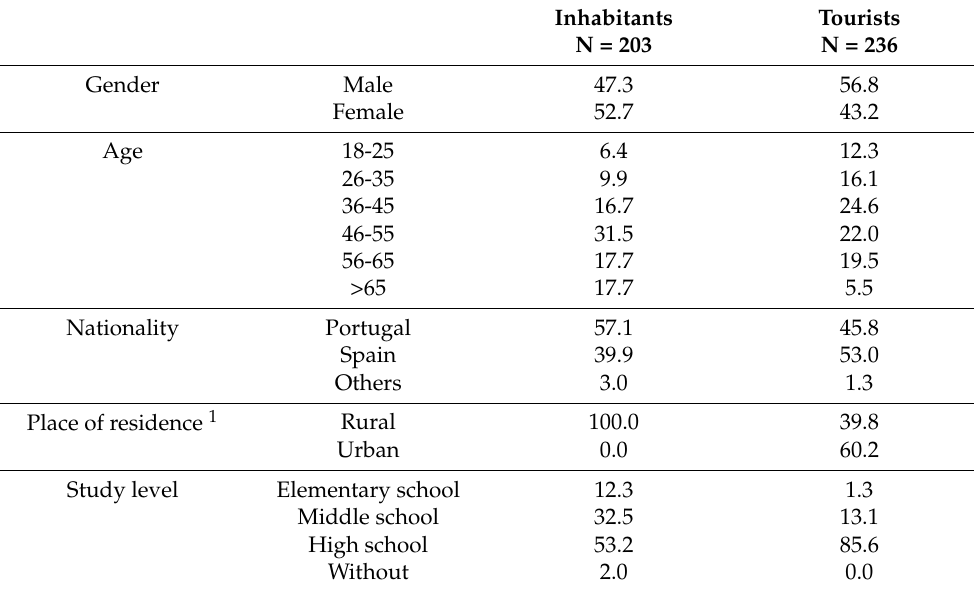
Table 1. Basic demographic information for the